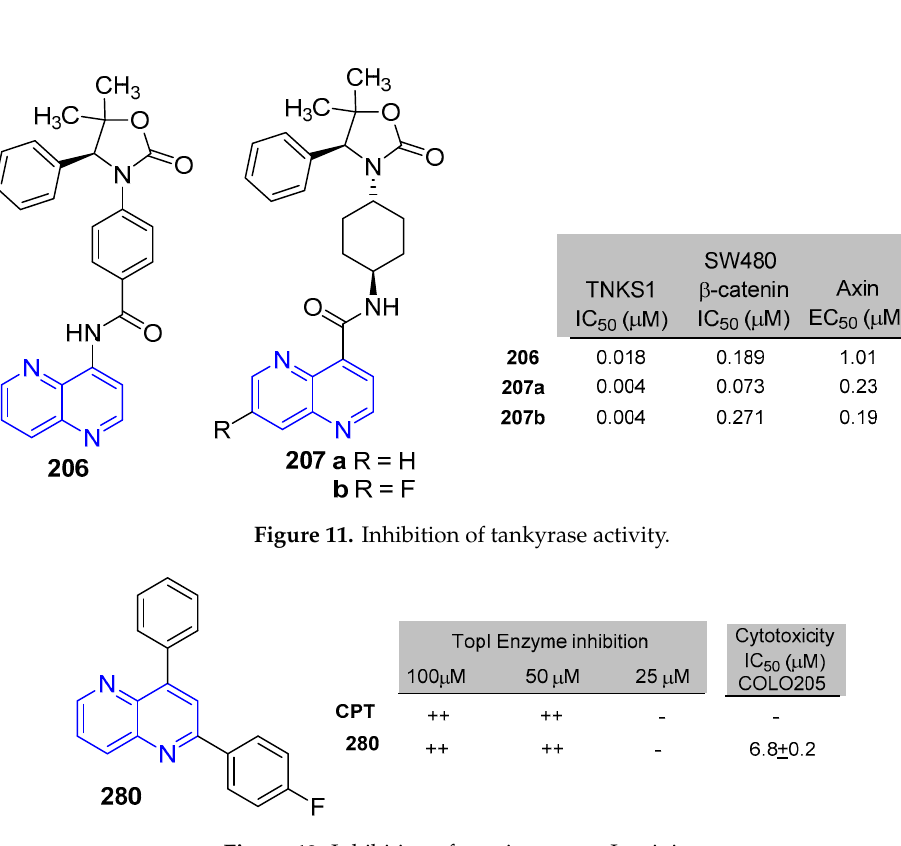
Figure 12. Inhibition of topoisomerase I activity.